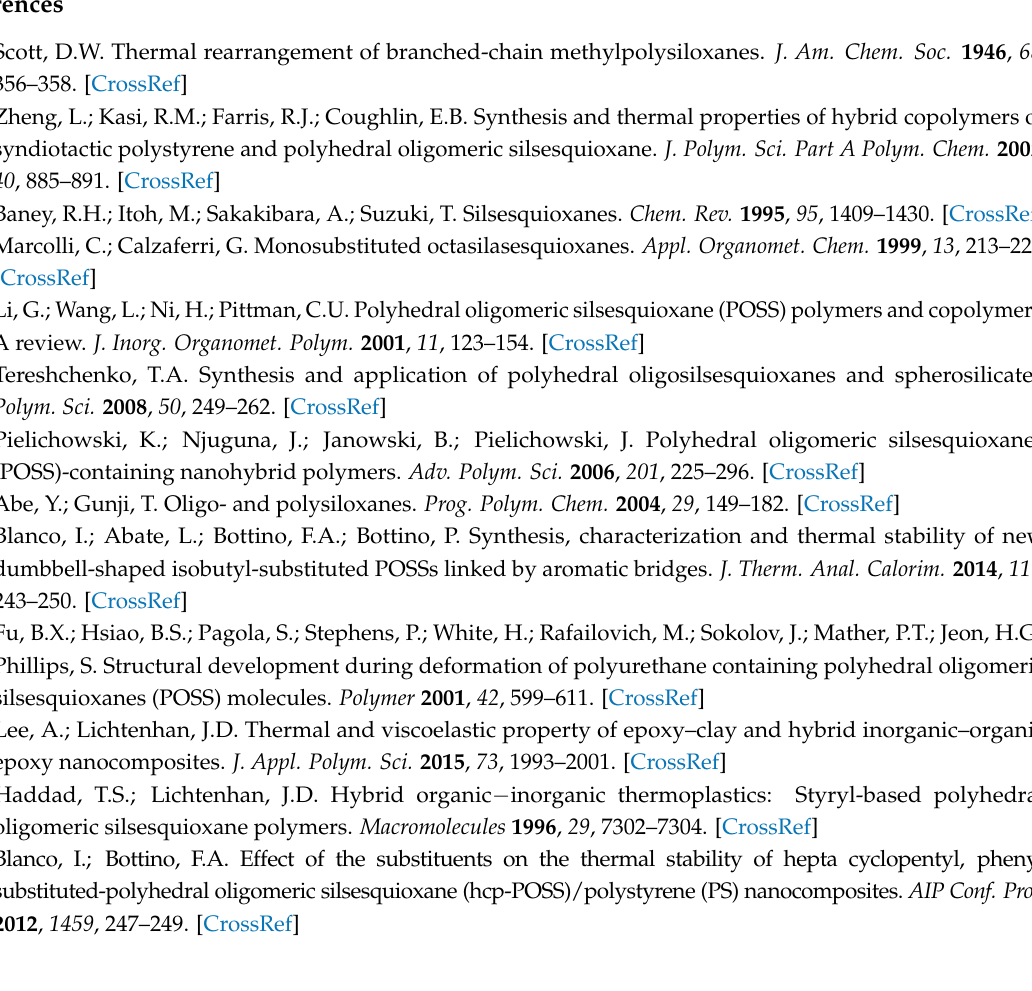
Figure S1: 1 H-NMR of the crystal 1 , Figure S2: 29 Si-NMR of crystal 1 , Figure S3: 1 H-NMR of polymer 1 , Figure S4: 29 Si-NMR of polymer 1 , Figure S5: 1 H-NMR of polymer 2 , Figure S6: 29Si-NMR of polymer 2 , Figure S7: 1 H-NMR of polymer 3 , Figure S8: IR of polymer 2 , Figure S9: GPC of polymer 1 , Figure S10: GPC of polymer 2 , Figure S11: TEM images of nanoparticle coated polymers and corresponding particle size distribution, Table S1: GPC result summary of polymer 1 and polymer 2 , Table S2: Unit cell parameters of crystal 1 . The cif file of crystal 1 was deposited in CCDC database with the code of 1835605, which can be obtained free of charge from the Cambridge Crystallographic Data Center. The cif file was also provided in the supplementary